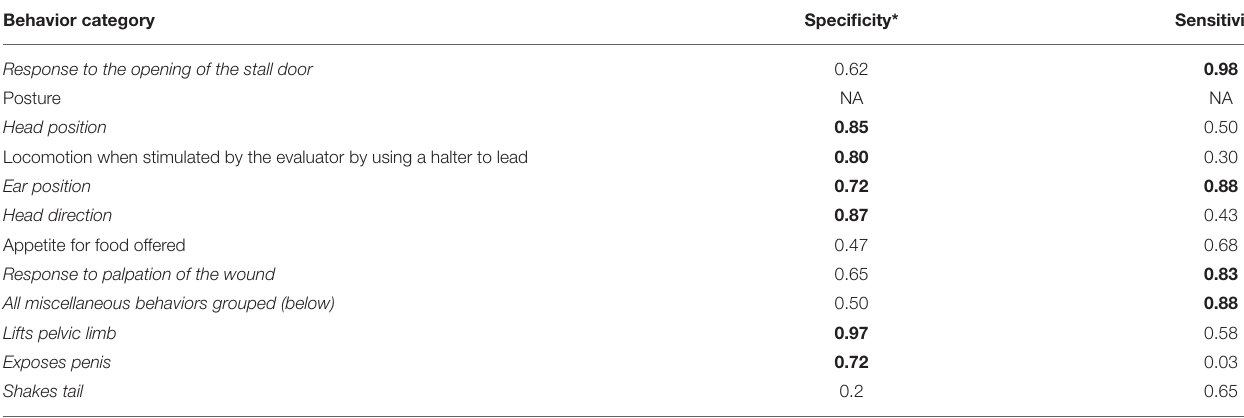
TABLE 3 | Specificity and sensitivity of the donkey acute pain scale before